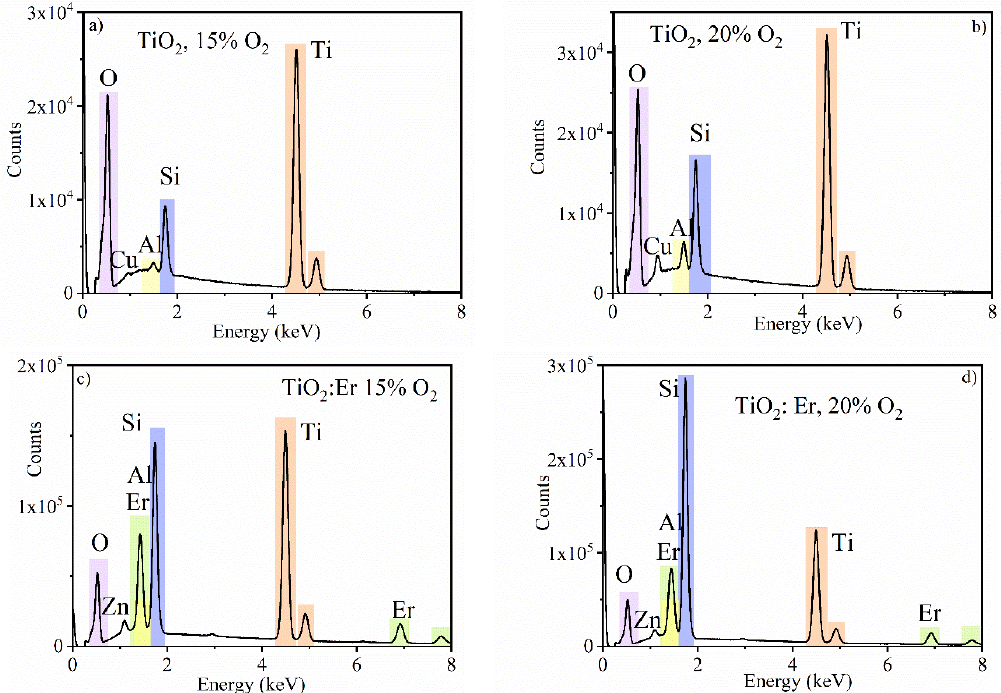
Figure 4. EDS analysis of TiO 2 thin films: undoped TiO 2 deposited at: ( a ) 15% O 2 and ( b ) 20% O 2 ; and TiO 2 :Er deposited at: ( c ) 15% O 2 and ( d ) 20% O 2 .